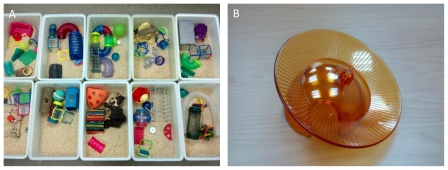
The enriched environment and running wheel used in this study.(A) The photo shows cages with different toys, including tubes, ladders, houses, balls. The toys in the enriched cages were changed every three days. (B) The running wheel used with the exercise group.